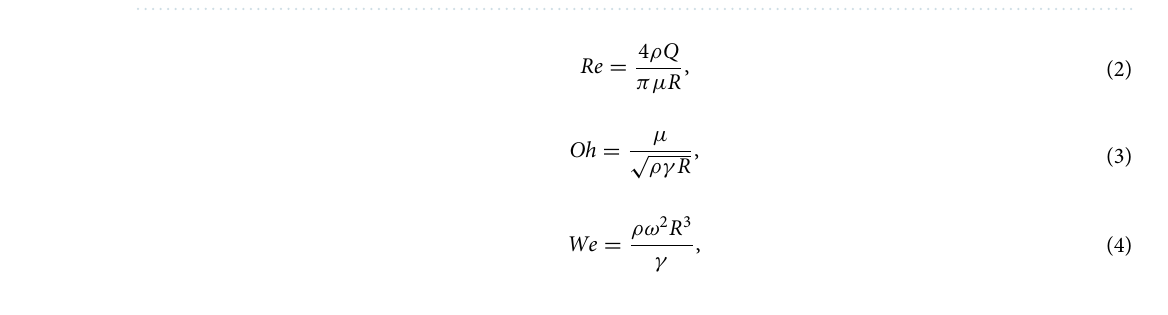
Figure 14. Schematic of the ( a ) PREP process and the ( b ) computational domain in CtFD